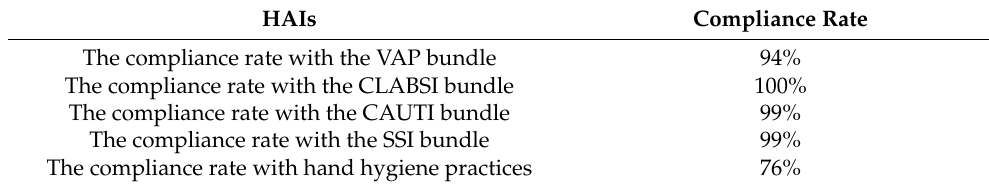
Table 4. Care bundle compliance rates.